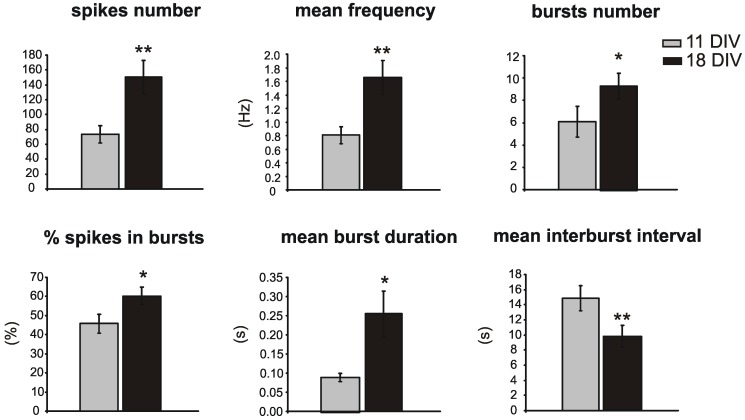
Firing frequency and bursts number increment with time in culture.Parameters characterizing electrical spontaneous activity of the hippocampal culture at DIV 11 (n = 29 MEAs; grey bars) and at DIV 18 (n = 36 MEAs; black bars) given as mean ± S.E.M. The difference between the two groups is statistically significant for all parameters (* p<0.05, **p<0.01 and ***p<0.001; using Student’s paired t-test). Spikes and bursts numbers both increased between 11 and 18 DIV. Number of spikes increased from 74±11 to 150±23 (p<0.01 ), while the number of bursts from 6.1±1.4 to 9.4±1.2 (p<0.05). The Maturation of the culture led to a prolongation of bursts duration (from 0.09±0.01 s at 11 DIV to 0.26±0.06 s at 18 DIV; p<0.02) and an increment of the percentage of spikes in the burst (46±5% vs 60±5%; p<0.03). Prolonged bursts and higher frequency on 18 DIV were accompanied by decreased mean interburst interval (IBI). Young cultures presented a mean IBI value of 15±2 s while, in mature cells (18 DIV), this interval was reduced to 9.7±1.4 s (p<0.01).